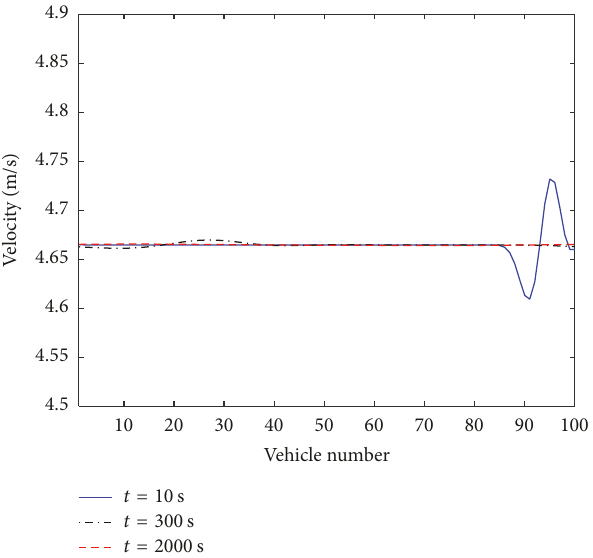
Figure 5: The snapshots of the velocity of all vehicles at different times for automated driving.